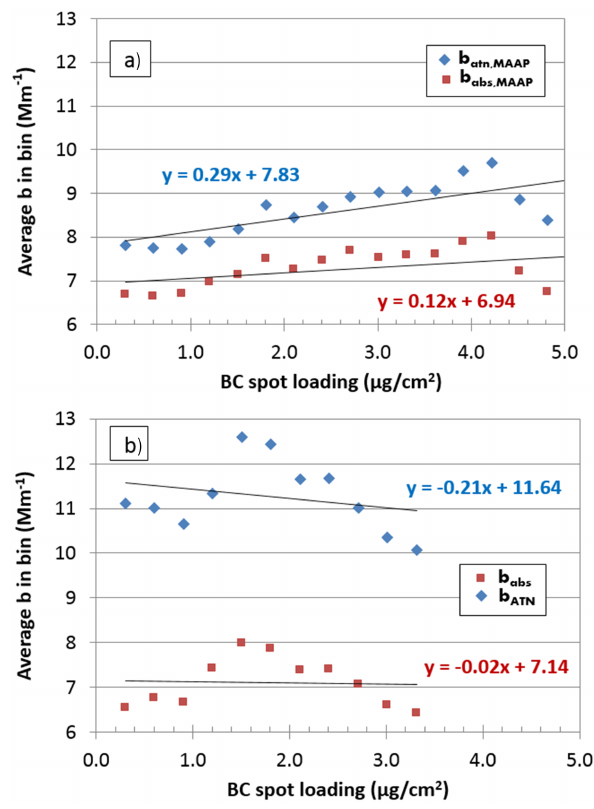
Figure 2. Average attenuation and absorption coefficient vs. loading of the spot: (a) the non-compensated MAAP attenuation coefficient b atn , MAAP and the compensated (Eq. 4) MAAP absorption coeffi- cient b abs , MAAP , and (b) the Aethalometer attenuation coefficient b ATN and the compensated (Eq. 7) Aethalometer absorption coeffi- cient b abs